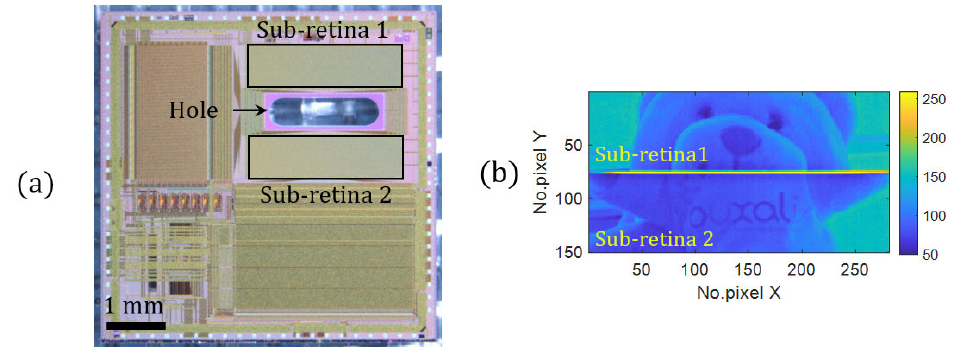
Figure 2. ( a ) Optical image of the fabricated holed retina. ( b ) Image example obtained focus mode.